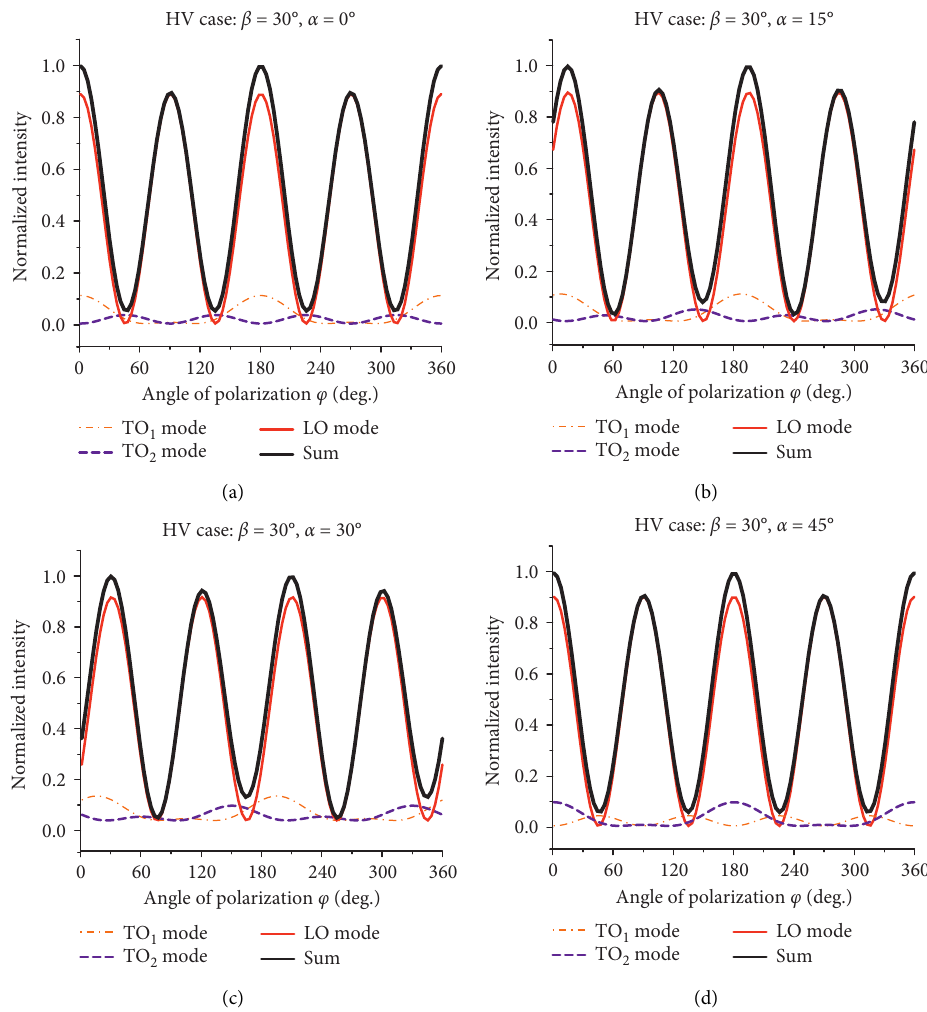
Figure 10: Intensity distributions of Raman modes in the HV case under the oblique backscattering configuration ( β � 30 ° ) for different polarization directions φ and sample rotation angles: (a) α � 0 ° , (b) α � 15 ° , (c) α � 30 ° , and (d) α � 45 °